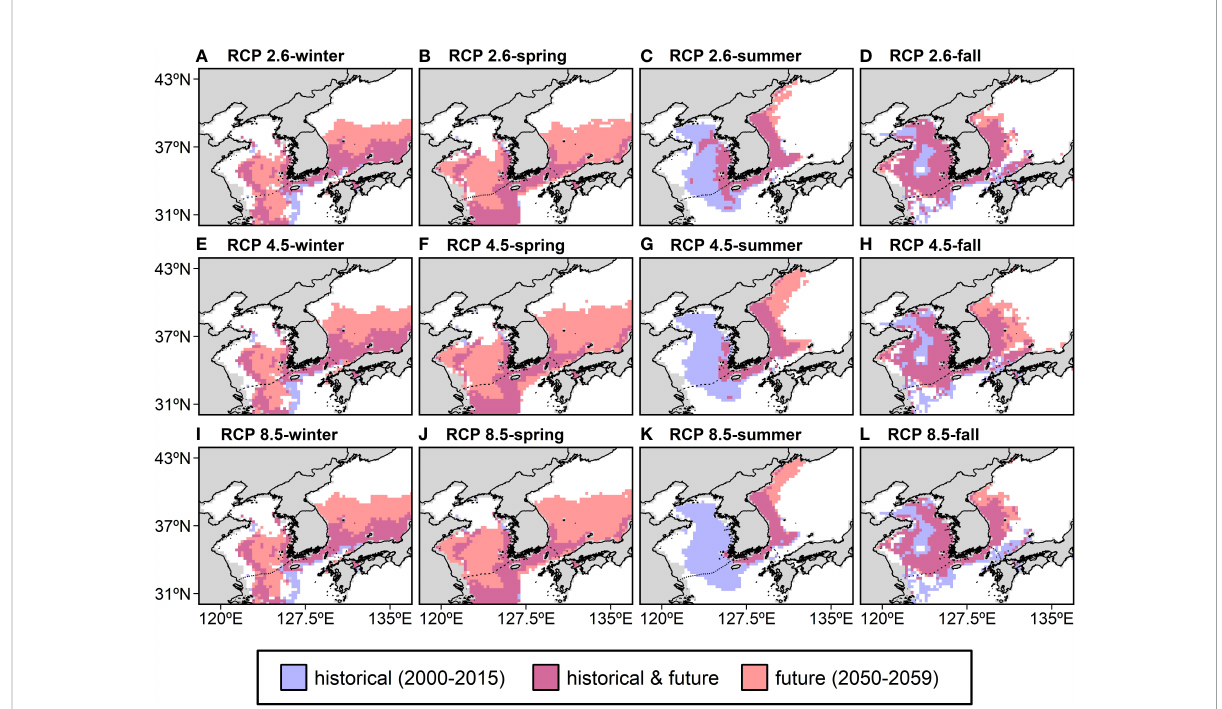
FIGURE 5 The seasonal changes in the spatial distribution of the anchovy habitat in the past (2000 – 2015) and future (the 2050s) under RCP 2.6 (A – D) , RCP 4.5 (E – H) , and RCP 8.5 (I – L) represent low (mitigation), medium (stabilization), or high (business-as-usual) greenhouse gas emissions, respectively. The anchovy habitat de fi ned areas with HSIs above the 10 th percentile of the training presence as thresholds. Blue indicates historical habitat, pink indicates future habitat, and purple indicates the habitat in both the historical period and the future. RCP; representative concentration